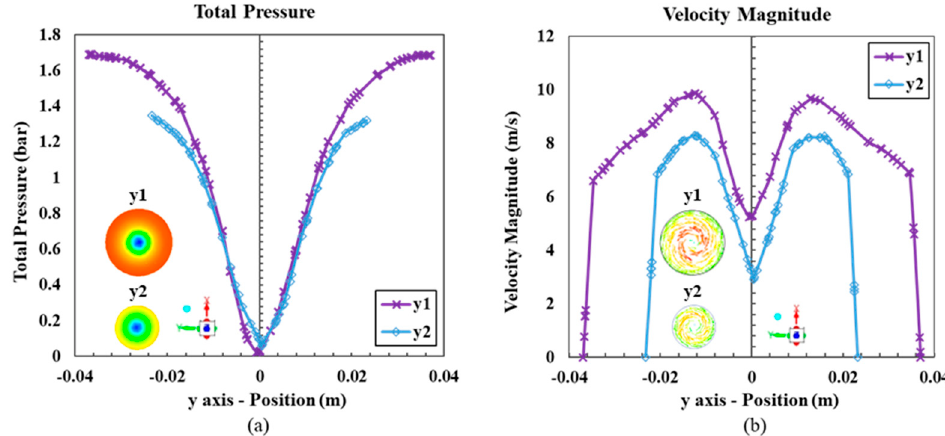
Figure 6. Distribution profile of Model 1 injected with 5 percent particles; ( a ) Total pressure and ( b ) Velocity magnitude.